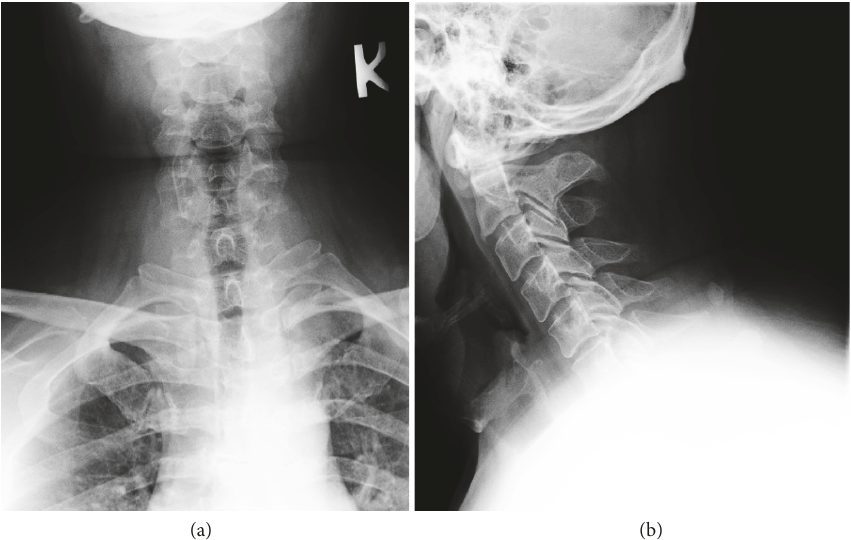
Figure 3: X-ray of the cervical spine. The foreign body is not visible in posteroanterior (a) and lateral (b)